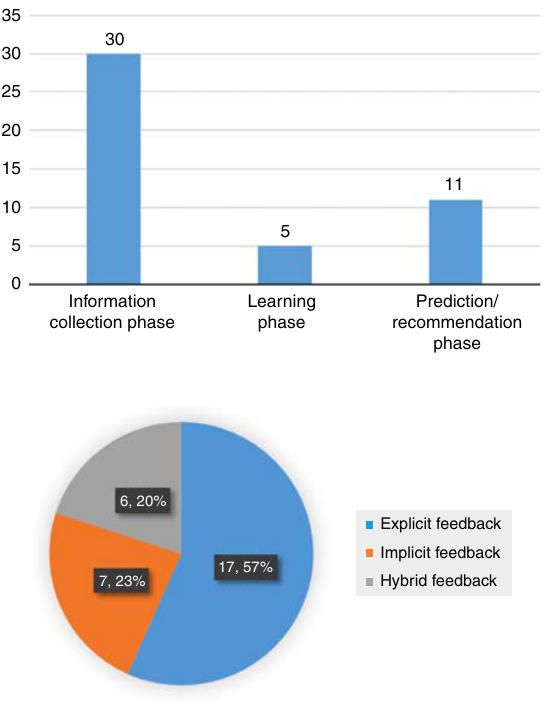
Figure 9. The distribution